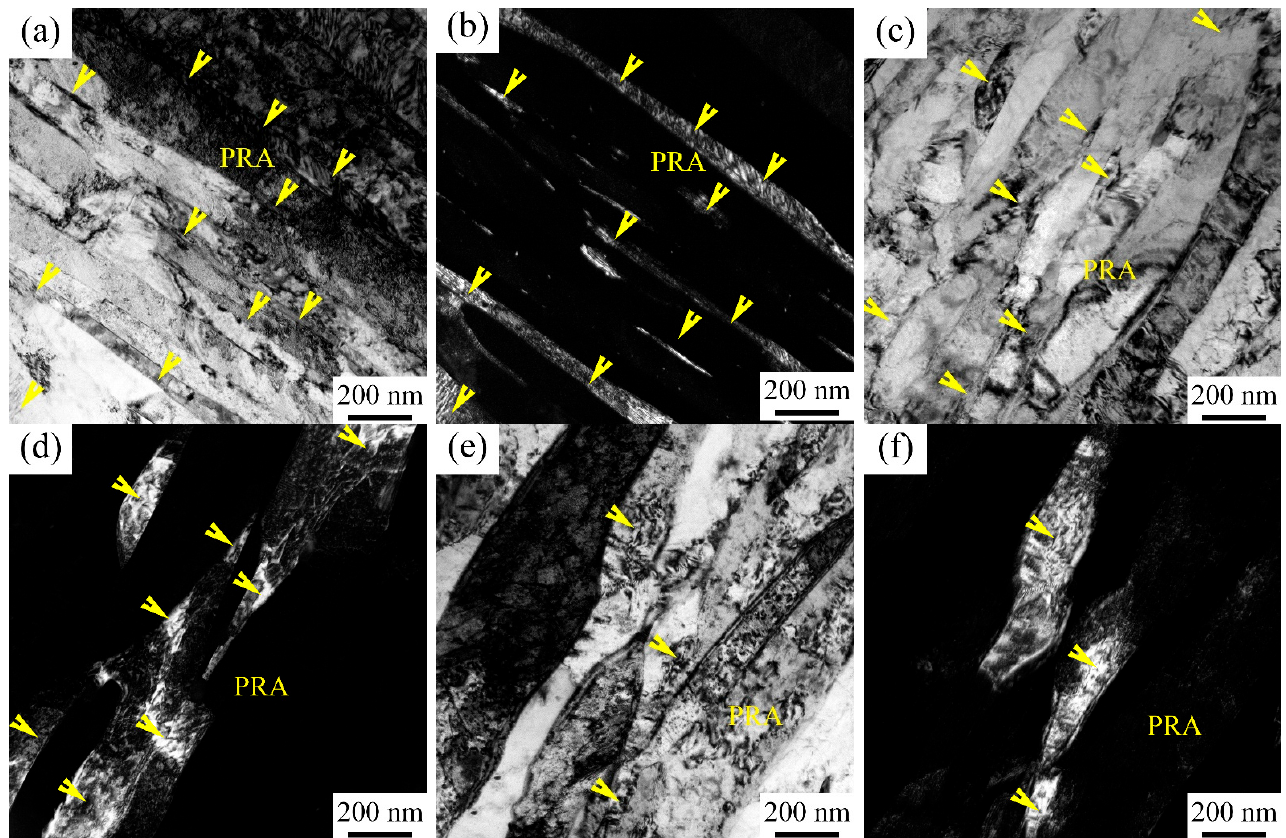
Figure 5. TEM images after being intercritically annealed at 650 °C: ( a , b ) IA-6 h; ( c , d ) IA-12 h; and ( e , f ) IA-50 h. ( a , c , e ) Bright field images; ( b , d , f ) dark field images.